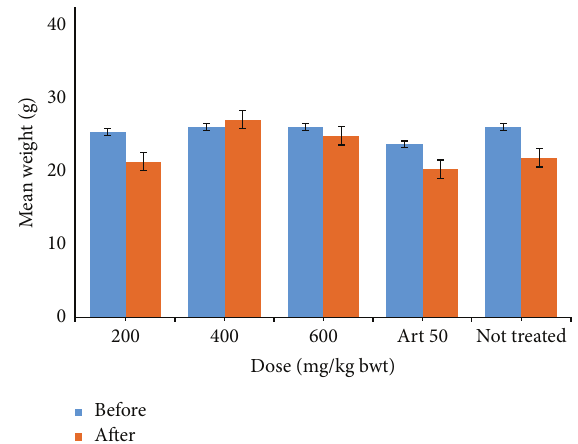
Figure 3: Effect of crude ethanol extract of P. guineense leaf on the mean body weight of Plasmodium berghei -infected